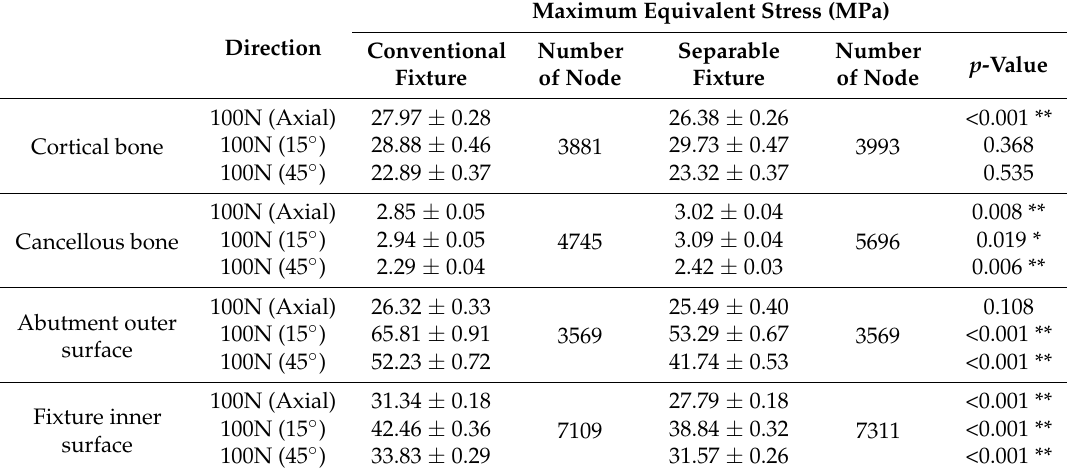
Table 3. FEA results (Mean ± SEM) of the conventional and separable fixtures for cortical bone, cancellous bone, abutment, and fixture (* p -value < 0.05, ** p -value < 0.01).